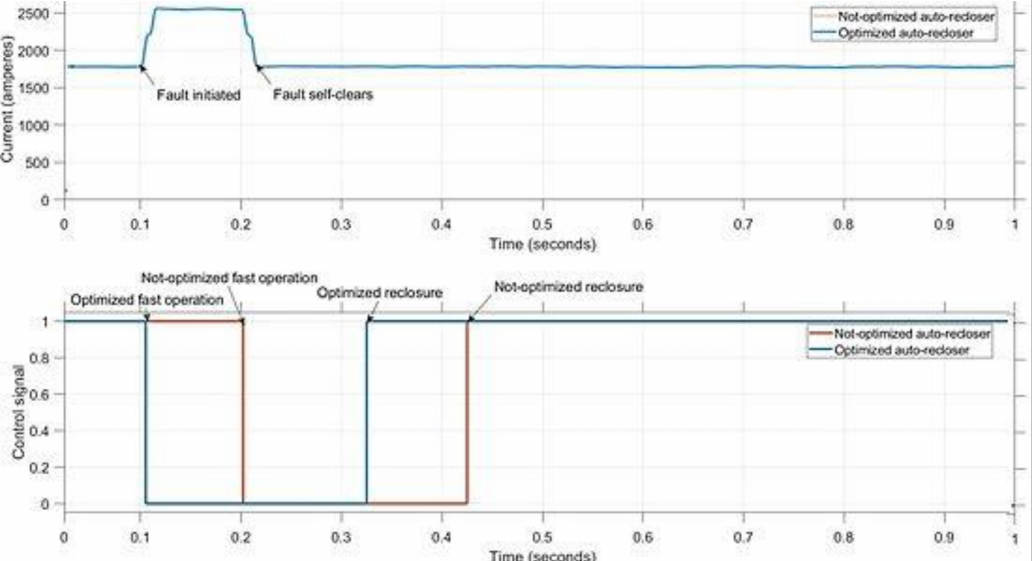
Figure 4. Comparison of the non-optimized and optimized operations for the recloser during a temporary fault.